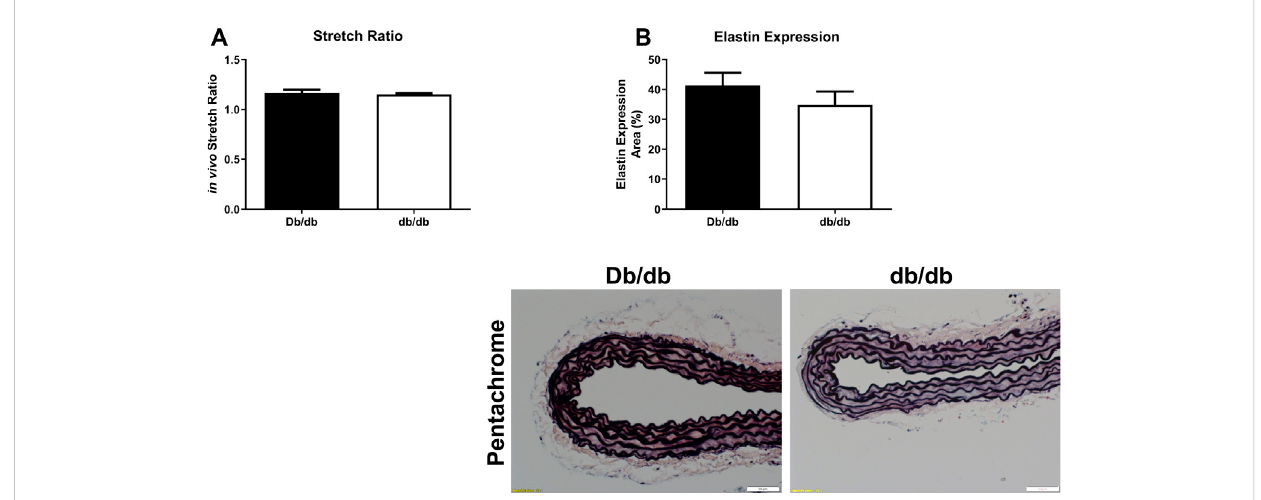
The aortic stretch ratios (A) was not different in diabetic db/db mice when compared to Db/db controls. p = N.S. n = 4 per group. (B) Pentachrome staining of normal (top left) and diabetic (top right) aortas revealed no overt differences in elastin staining (black laminar layers), nor did it reveal any